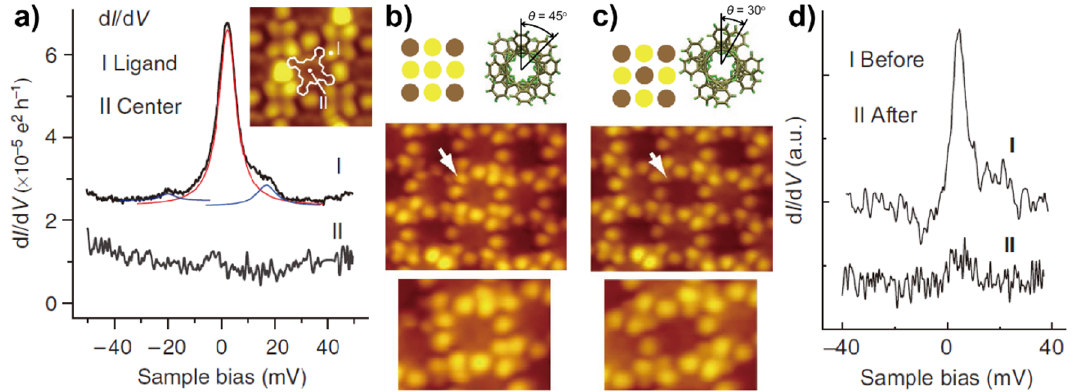
Figure 8. ( a ) d I /d V spectra recorded at the lobe and center of a TbPc 2 molecule on Au(111). Inset: STM image of TbPc 2 molecules in the assembled structure. Schematic illustrations and STM images of TbPc 2 molecules with ( b ) θ = 45° and ( c ) θ = 30°. ( d ) d I /d V spectra acquired at a TbPc 2 molecule before and after the application of a tip pulse. Adapted from [83], with permission from Macmillan Publishers Limited, 2011.